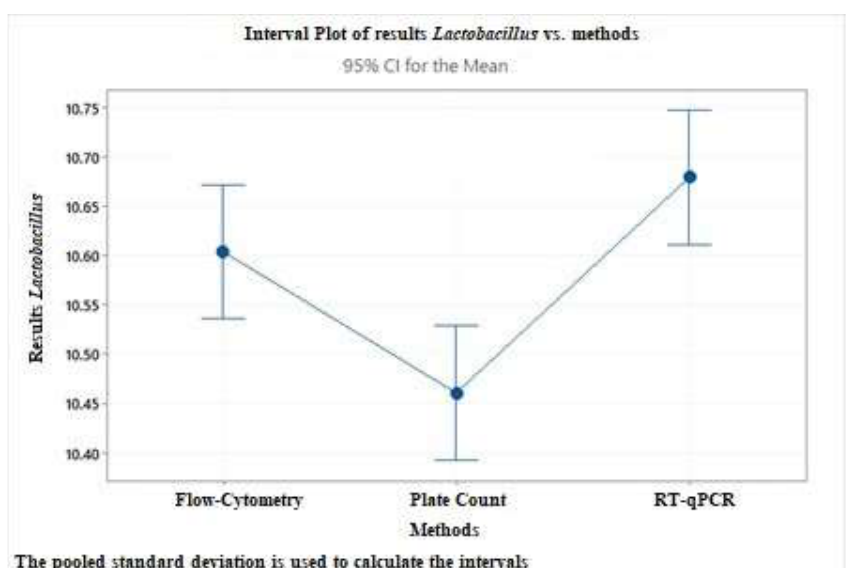
Figure 7. Interval graph representing the difference in counting between Lactobacillus spp. count in food supplement 2 obtained from the three methods tested. CI: confidence interval.